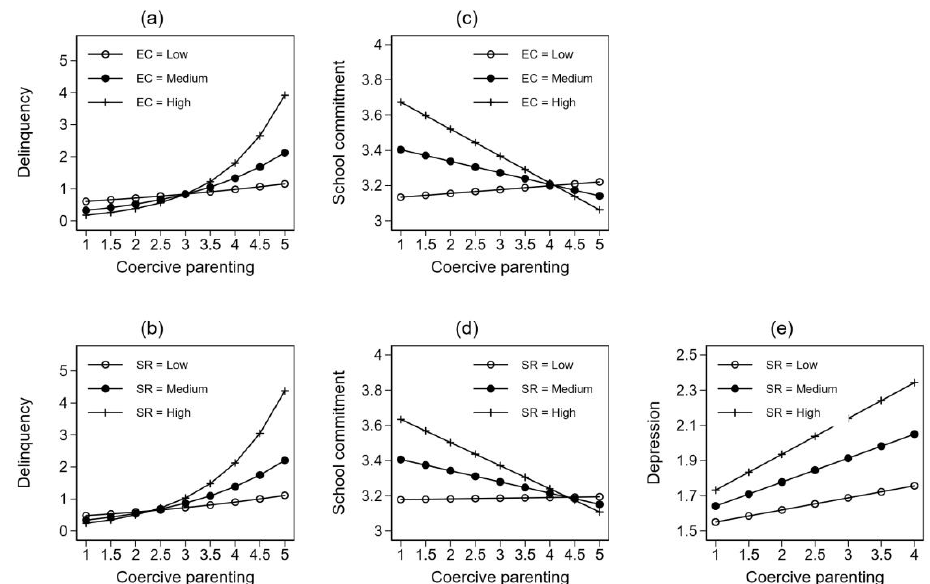
Figure 1. The marginal e ff ect of coercive parenting on developmental outcomes under di ff erent levels of empathic concern (EC) and perceived social rejection (SR). ( a ) Moderated relationship between CP and delinquency by EC. ( b ) Moderated relationship between CP and delinquency by SR. ( c ) Moderated relationship between CP and school commitment by EC. ( d ) Moderated relationship between CP and school commitment by SR. ( e ) Moderated relationship between CP and depression by